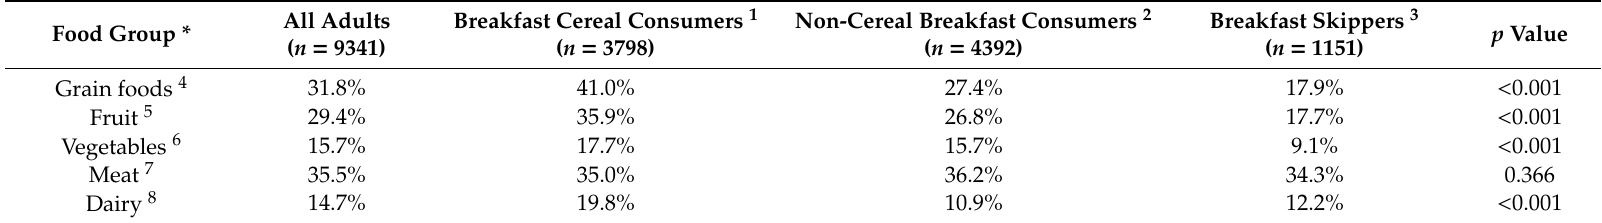
Table 2. Prevalence of adults meeting the recommended serves of the Five Food Groups by breakfast consumer category.